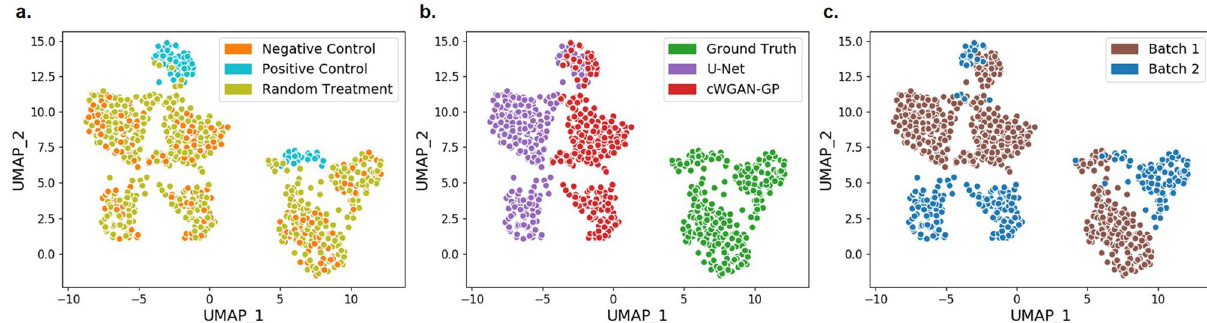
Figure 6. The UMAPs demonstrate that both models could reproduce the separation between treatments and batches seen in the ground truth features and that the clustering patterns are very similar. ( a ) shows each test image labelled by treatment type, ( b ) shows ground truth vs the two models and ( c ) highlights the difference between the two batches. cWGAN-GP was closer to the ground truth than U-Net, although the two models sit much closer to each other in feature space than either to the ground